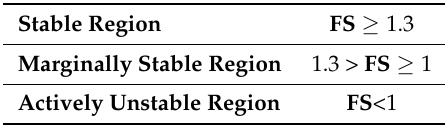
Table 2. Classification of Factor of Safety (FS)